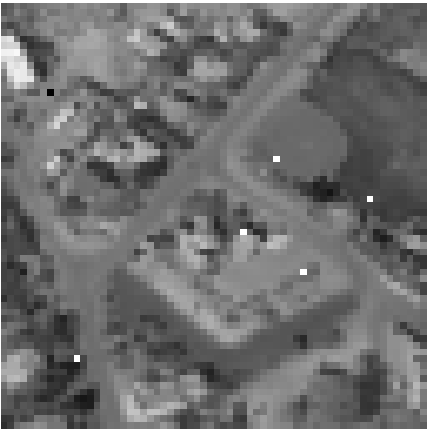
Figure 6. Low resolution with salt and pepper noise